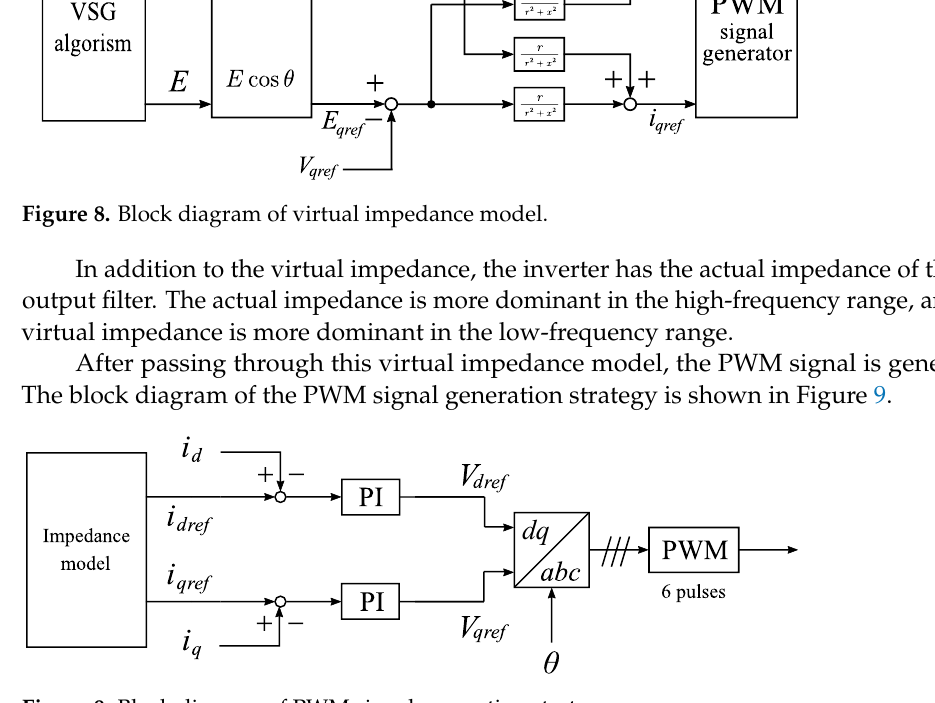
Figure 9. Block diagram of PWM signal generation strategy.